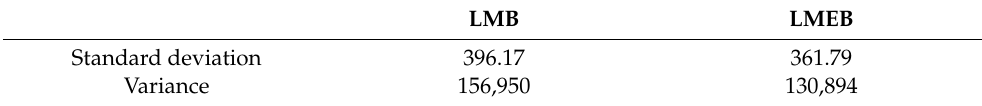
Table 11. Results of statistical analysis of energy